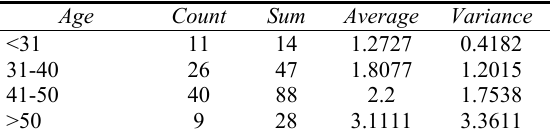
Table 2. Summary of statistics from question Q12 Age